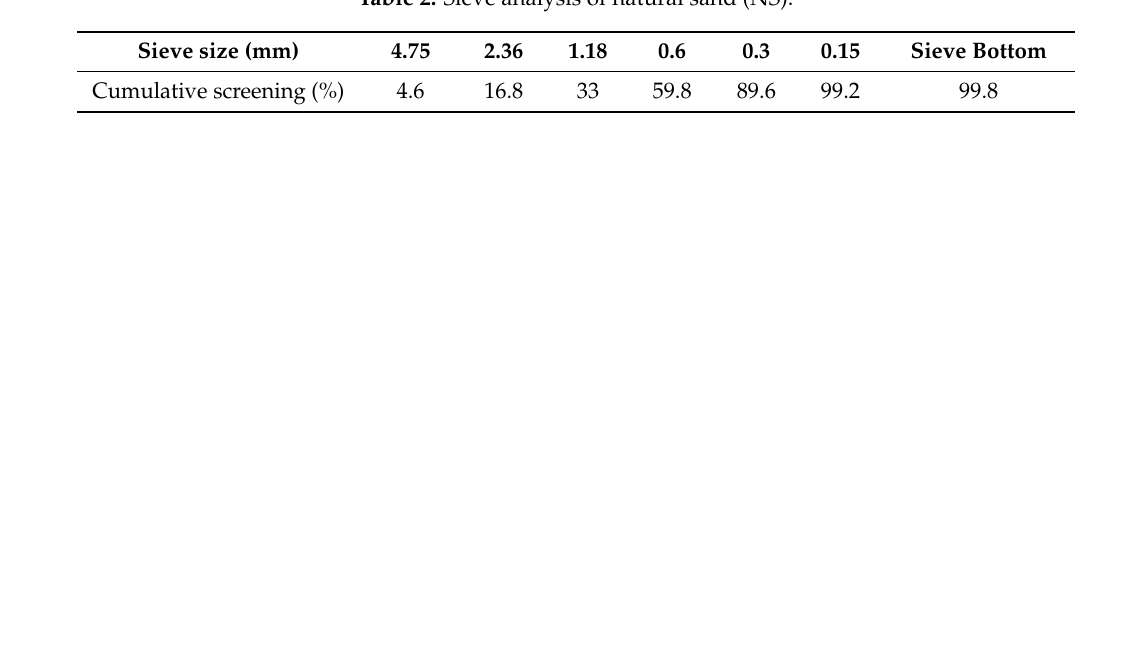
Table 2. Sieve analysis of natural sand